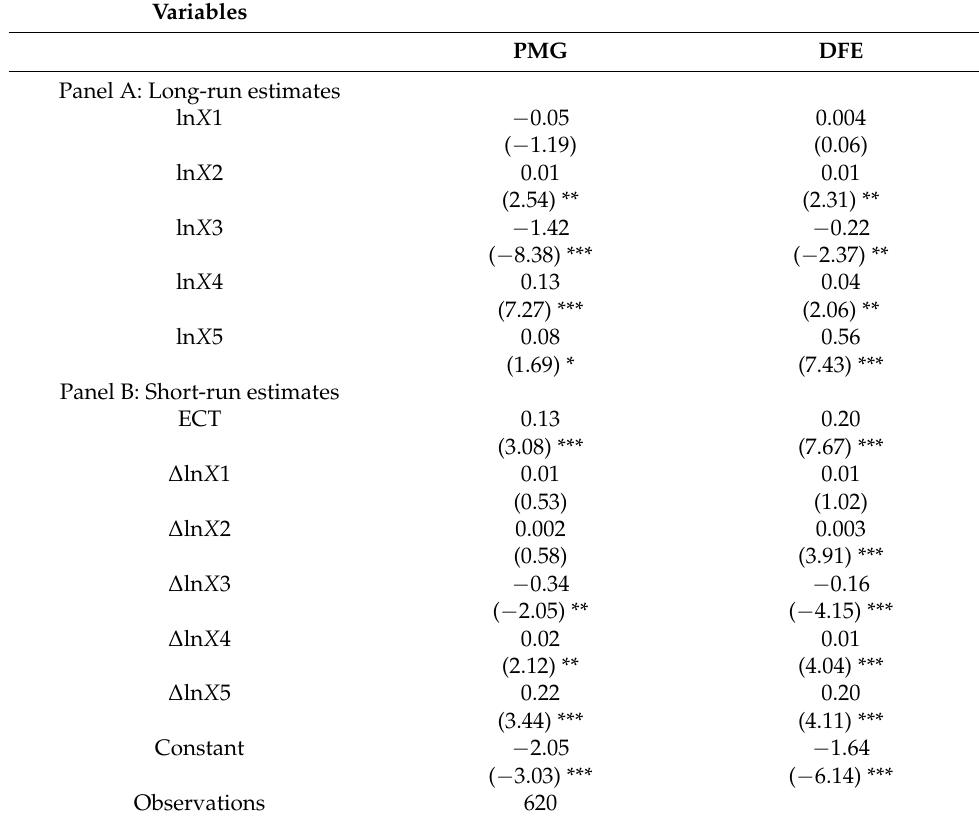
Table 9. Panel ARDL results from pooled mean group and mean group